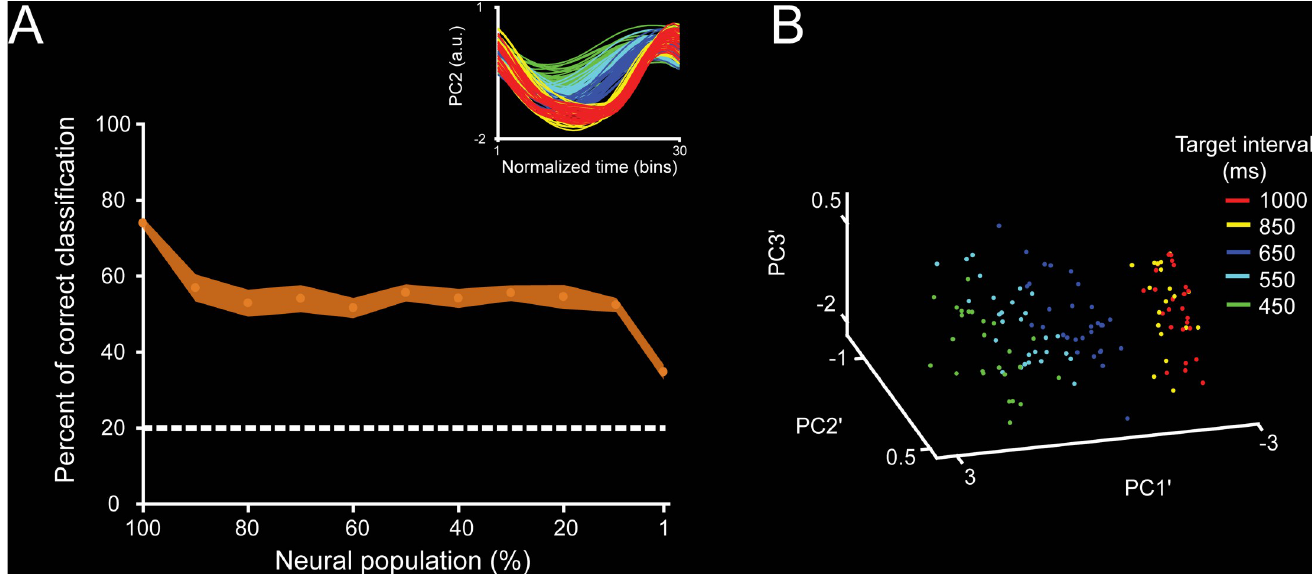
Fig 7. Trajectory classifier robustness across neural population sizes during SCT. A . SVM classifier performance (mean ± SD of percent of correct classifications) for target interval (five instructed intervals) during the SCT task based on the neural trajectory computed from different population sizes. The total initial population size was of 1,477 neurons. Dotted lines correspond to random level. The neurons with the largest PC participation were removed in steps of 10% of the original population size, until reaching 1% of the original population. Inset shows the original time-normalized neural trajectory PC used to generate the second-layer PCA 0 . B . Point cloud in 3D for the second-layer PCAs’ for target interval. See color code in the inset. Note that the percentage of correct classification decreased as a function of the population size; however, the classification was above chance even for the trajectories based on small cell ensembles. Underlying data are available